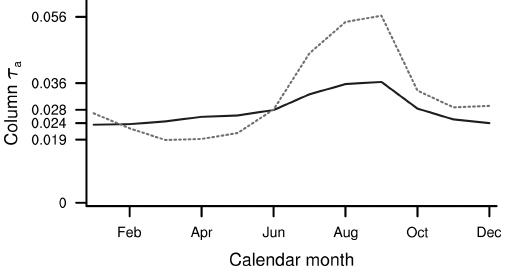
Figure 5. Variation of the column and globally averaged anthro- pogenic aerosol optical depth (550nm) over the annual cycle. Shown are values for the year 2005 for the global average (solid) and for the deep tropics equatorward of 15 ◦